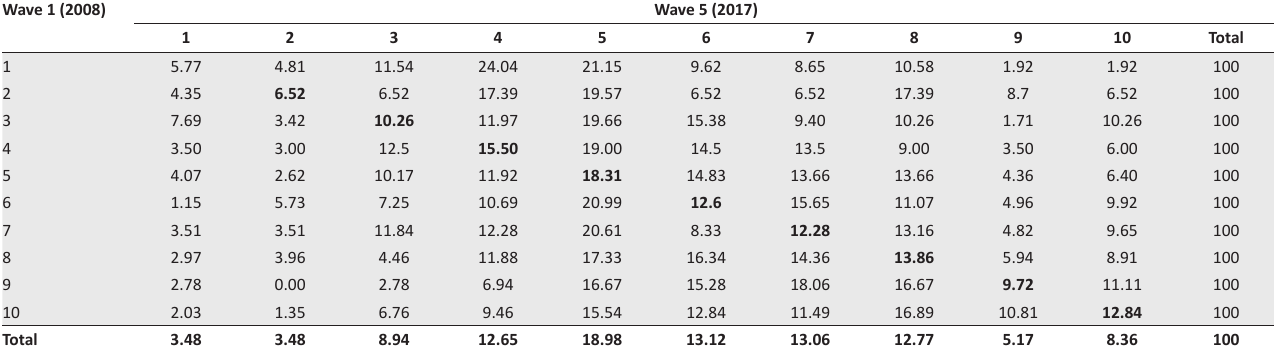
TABLE 2: Subjective well-being transition dynamics, 2008 and 2017 (percentage). Wave 1